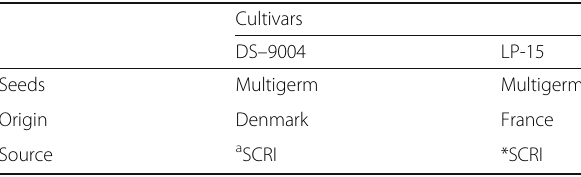
Table 1 Origin and sources of sugar beet ( Beta vulgaris L .) cultivars used in this